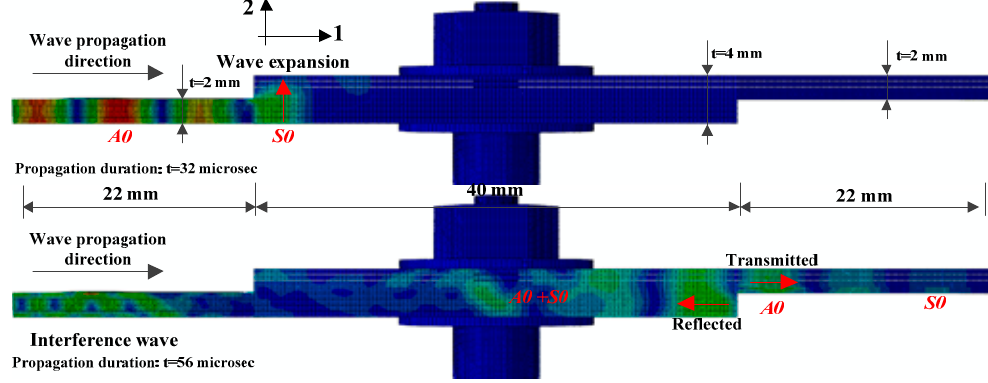
Figure 16. Displacement fields (U2) of Lamb waves in the composites bolted joints for an excitation frequency of 210 kHz obtained in the FE simulations.